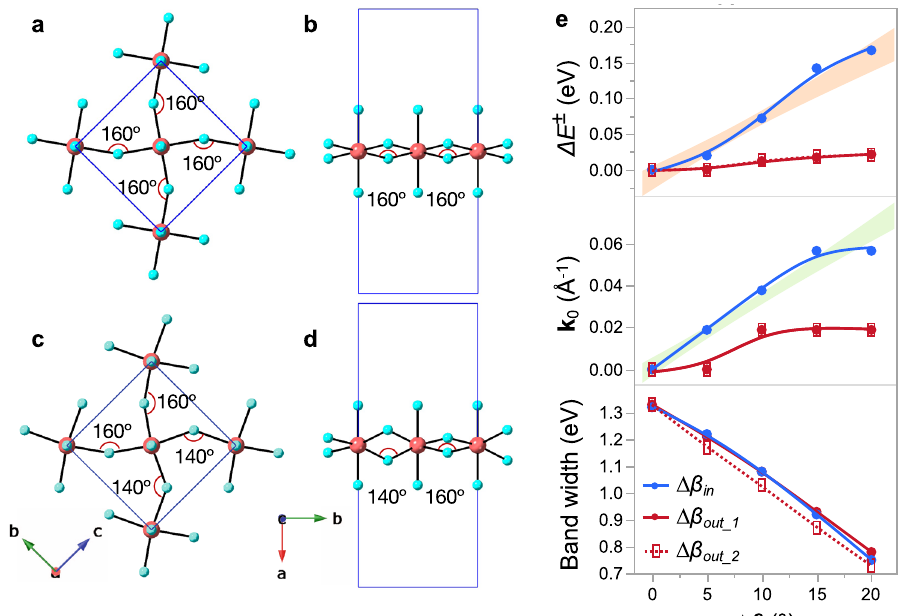
Fig. 6 First principles simulations on 2D Cs 2 PbBr 4 models. a , b Representative ( √ 2 × √ 2) − R45° Cs 2 PbBr 4 models with symmetrical in-plane ( a ) and out-of-plane ( b ) tilting of adjacent PbBr 6 octahedra, i.e., with Δ β ¼ 0. c , d Representative ( √ 2 × √ 2) − R45° Cs 2 PbBr 4 models with asymmetrical in-plane ( c ) and out-of-plane ( d ) tilting of adjacent PbBr 6 octahedra with Δ β in ; out ¼ 20 (cid:4) . e Plots showing the evolution of lowest conduction subband energy width, k 0 , and Δ E ± along the spin-splitting k-path as a function of Δ β in and Δ β out in the series of Cs 2 PbBr 4 models. See Supplementary Fig. 16 and Supplementary Note 2 for details. The legends Δ β out and Δ β out in ( e ) correspond to the models with and without formal dipole on the Pb site, respectively. The shaded 1 2 regions in ( e ) are 95% con fi dence intervals of fi tting as a function of Δ β in in Fig.